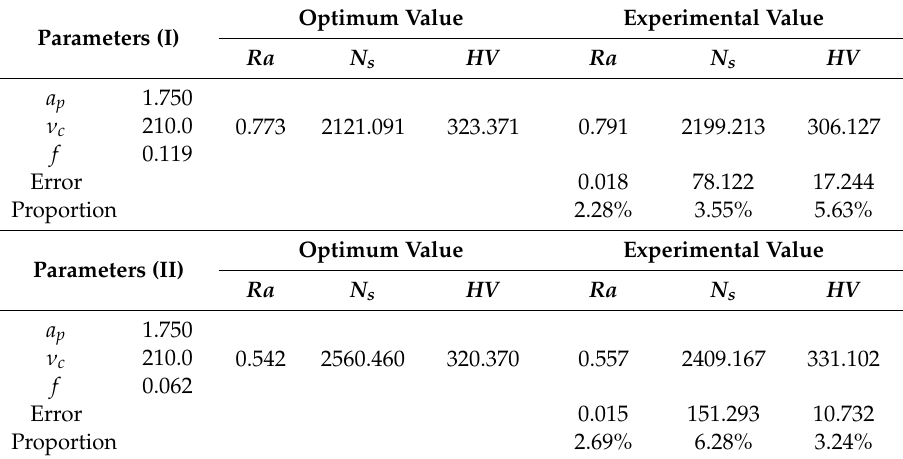
Table 14. Results of confirmation experiment for responses.